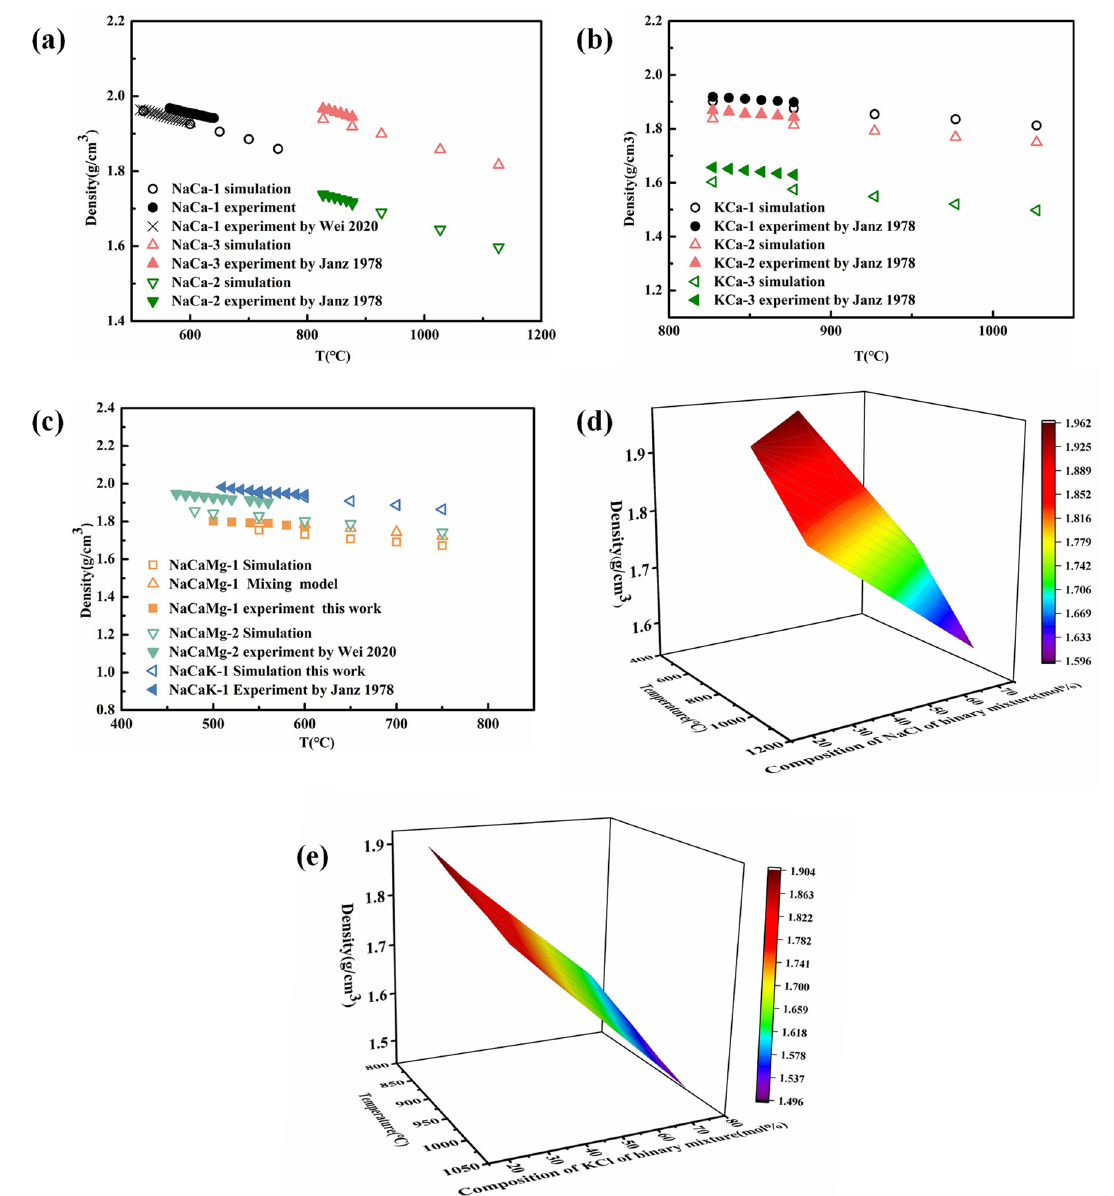
Figure 4. Density of chloride eutectic molten salts of ( a ) binary NaCl-CaCl 2 , ( b ) binary KCl-CaCl 2 , ( c ) ternary NaCl-CaCl 2 -MgCl 2 vs. temperature, density of full composition of ( d ) NaCl-CaCl 2 and ( e ) KCl-CaCl 2 [4,28].